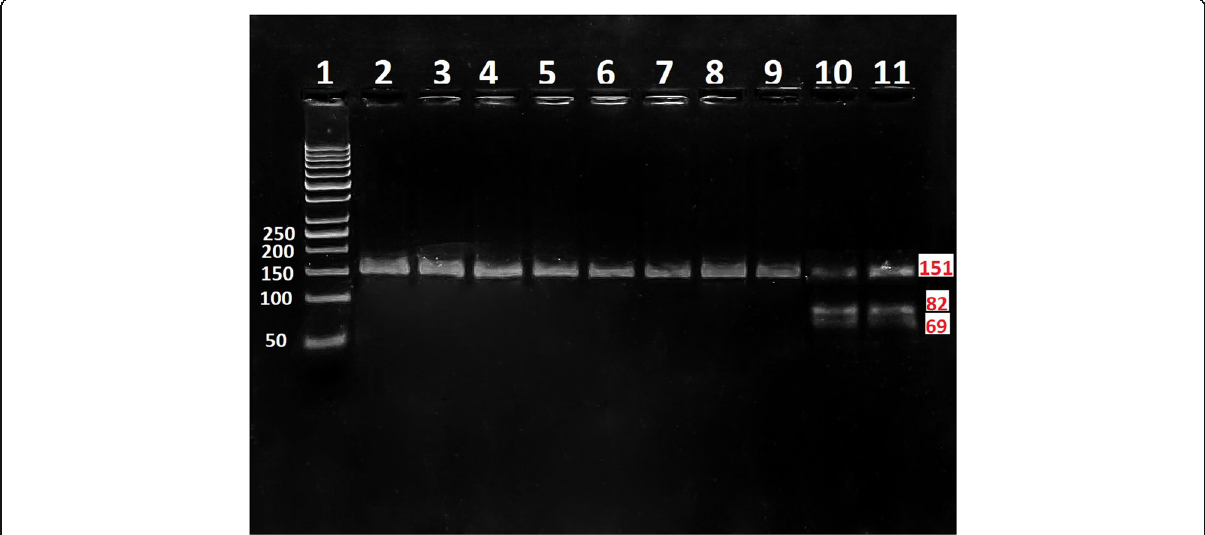
Fig. 1 Three percent agarose gel electrophoresis of EcoR1 restriction enzyme products. Lane 1 contains a 50 bp DNA ladder; lanes 2 – 9 show the (G/G) genotype represented by one band of 151 bp; and lanes 10 – 11 show the (G/T) genotype represented by three bands of 152 bp, 82 bp, and 69 bp